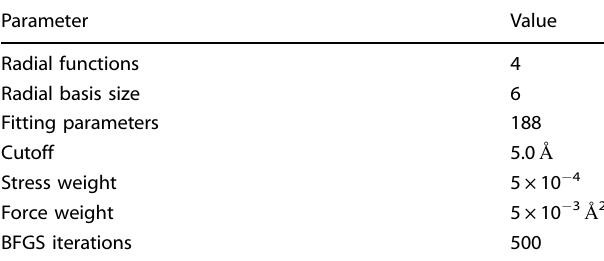
Table 3. Parameters for the MTP model.